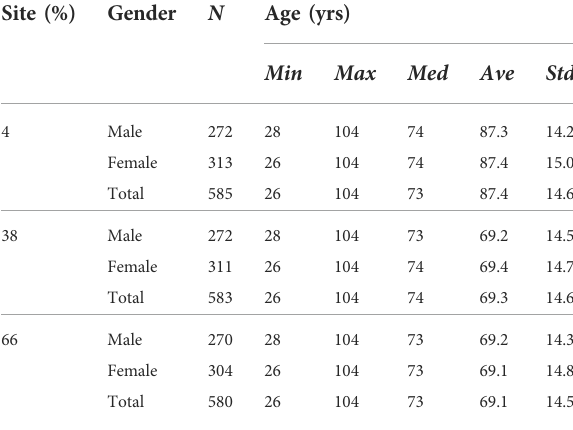
TABLE 2 Summary of the unlabeled pQCT scans of the lower leg from the InCHIANTI